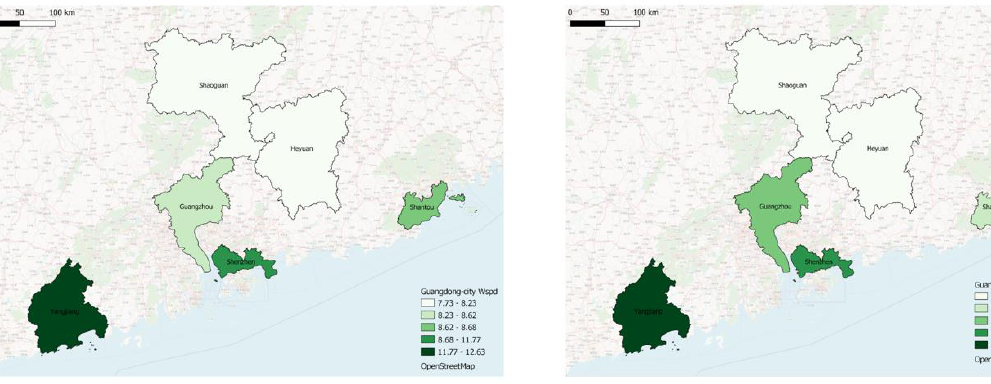
Figure 9. Comparison of Guangzhou with five other cities—average and peak values of temperatures, precipitation and windspeed for 1991 – 2022.